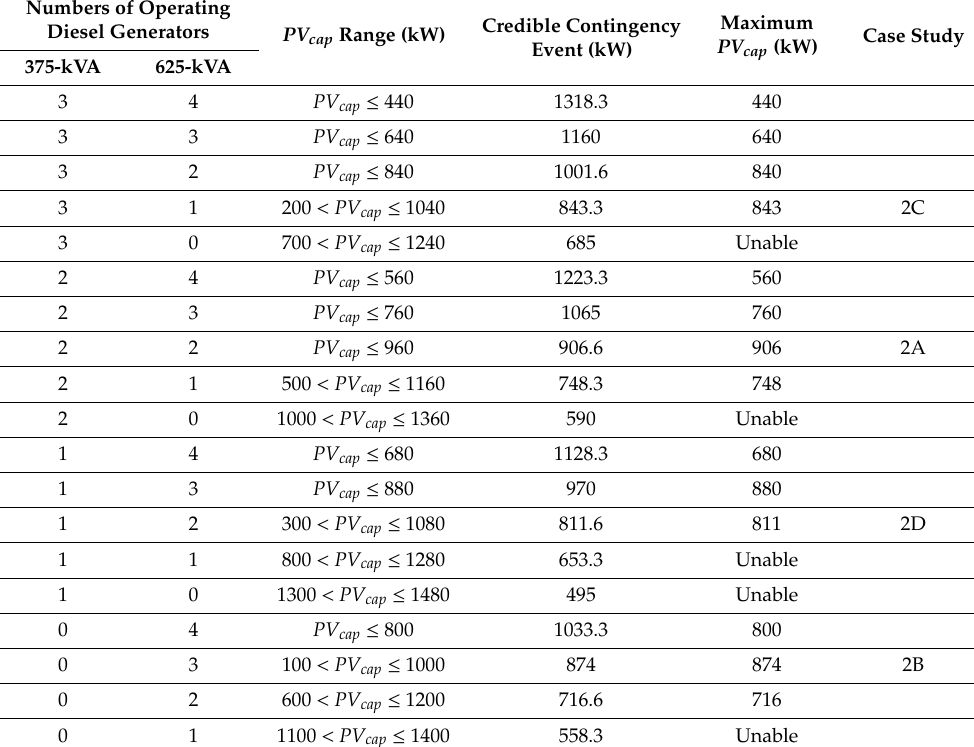
Table 6. Mathematical analysis results for quasi-steady-state frequency with the